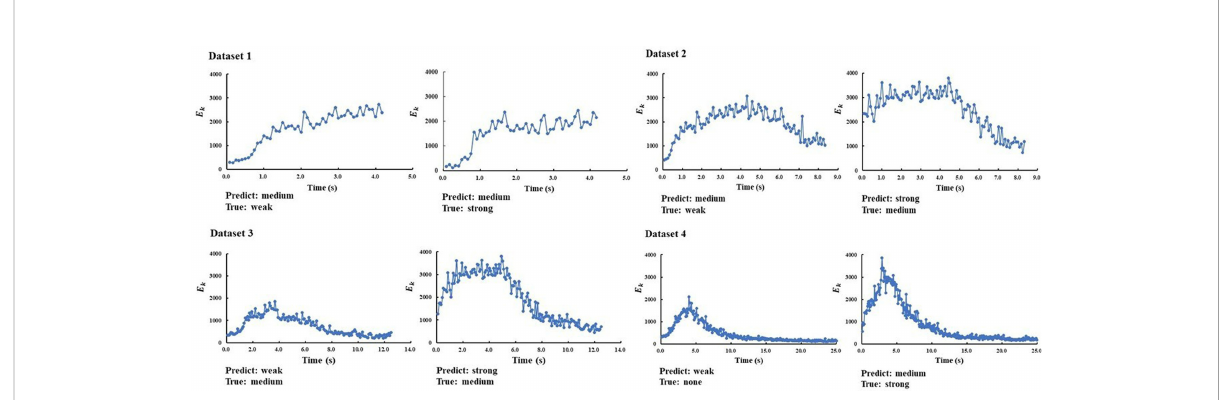
FIGURE 9 False recognition examples of the RNN-based method model in different